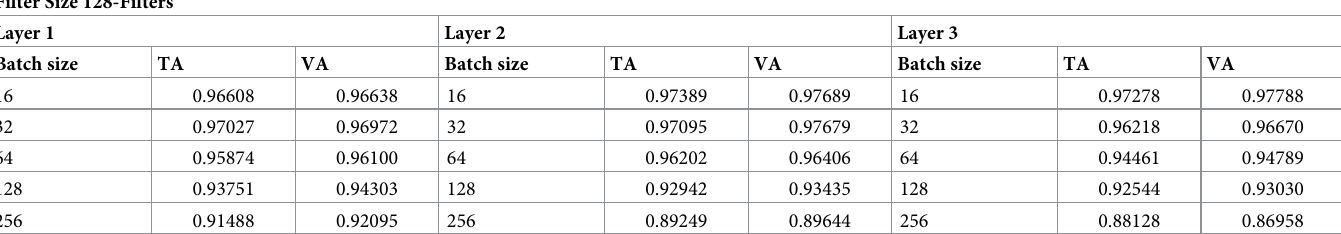
Table 3. Experimentation results of ConvLSTM with 128-Filters.